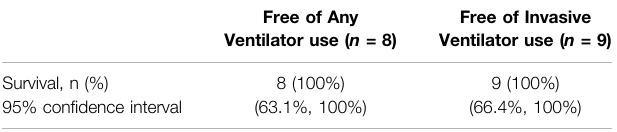
TABLE 2 | Survival under different ventilation conditions at week 52.